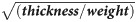
Relative thickness of quandong stones.Relative thickness ((thickness/weight)) plotted against relative area ((lengthxwidth)). Perceived forms are clearly differentiated, with the ‘classic’ quandong stones circled. The smaller, more rounded items are relatively thicker and cluster in the upper left. The larger, more typically mortar-like items are relatively thinner and cluster on the right. The regression line is calculated only for the items on the left, illustrating their relative similarity contrasted with the mortar-like items on the right. Labelled items are illustrated in other figures.